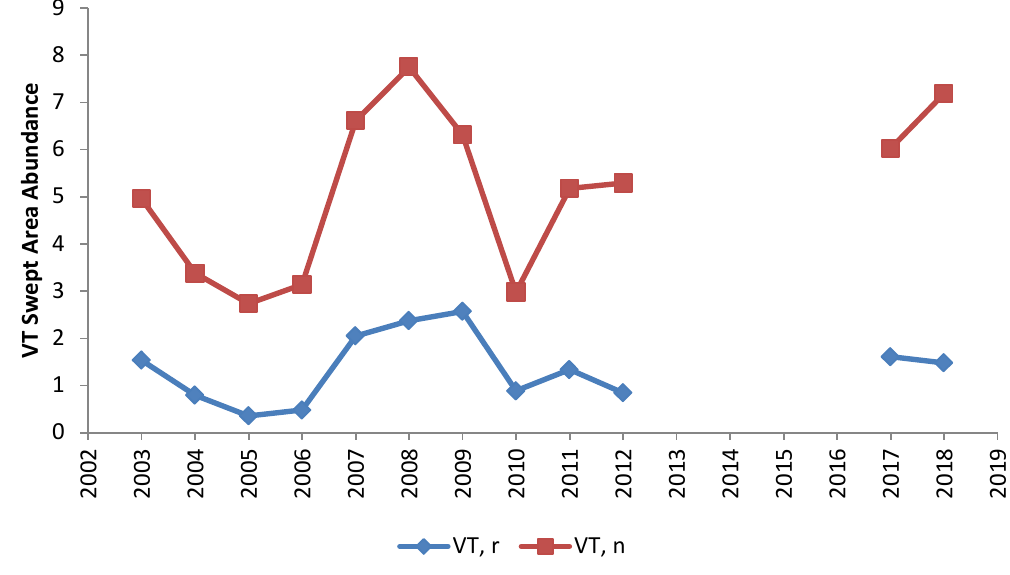
Figure 95. Primiparous and multiparous indices (in millions) from the Virginia Tech Trawl